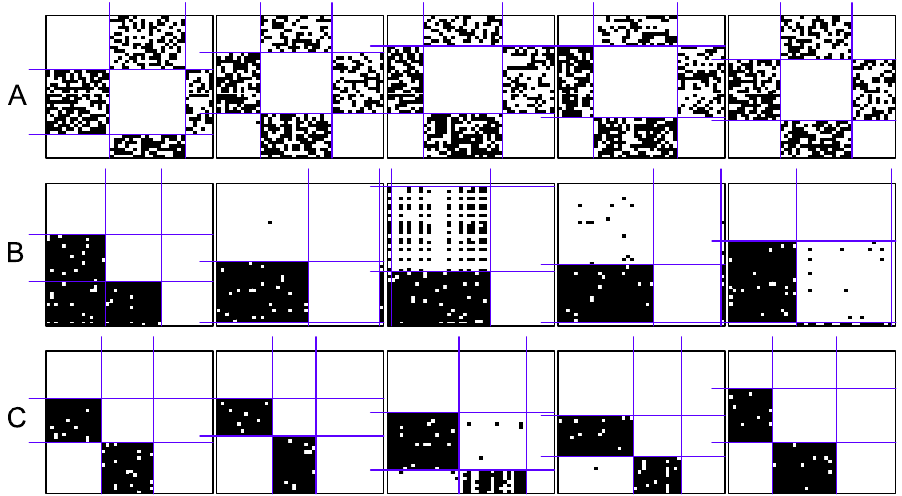
Fig 9. Some generated networks with a hierarchical blockmodel structure without complete blocks on the diagonal using different models. The networks are generated by the MCMC algorithm with a non-fixed density. (a) All selected types of triads; (b) All selected types of triads and paths of length three; (c) All selected types of triads (with a higher parameter value for the triad of type 021D) and paths of length three.